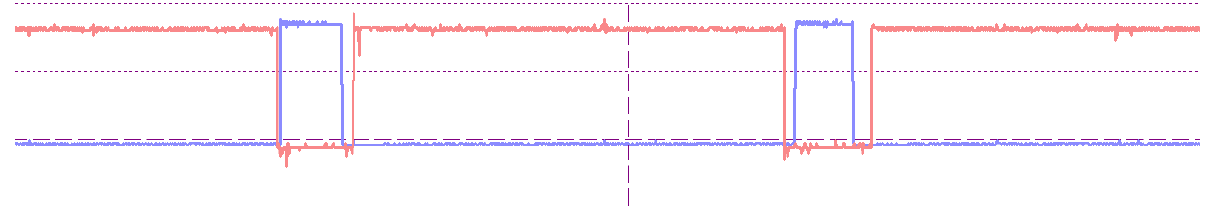
Figure 15. PWM of phase